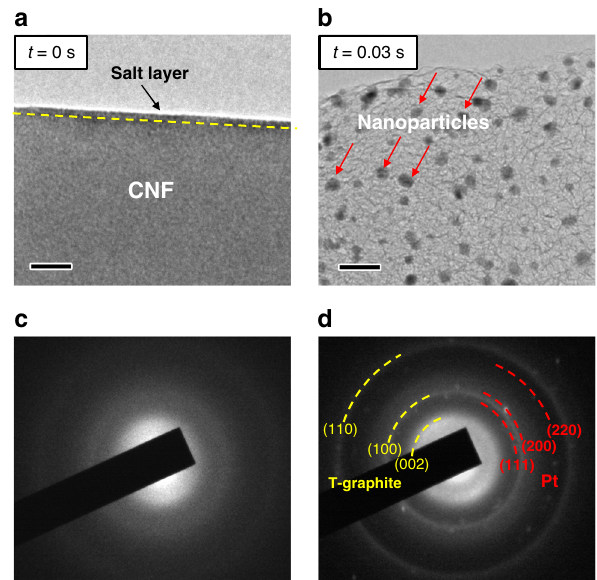
Fig. 2 Structural evaluation of salt-loaded amorphous CNF during Joule heating process. a , b Bright fi eld TEM images of the S-CNF at t = 0 s and t = 0.03 s, respectively, and c , d the SAED patterns of pristine S-CNF and Joule heated S-CNF, showing the crystallization of CNF and the formation of metallic Pt nanoparticles, respectively. Scale bars are 20 nm.